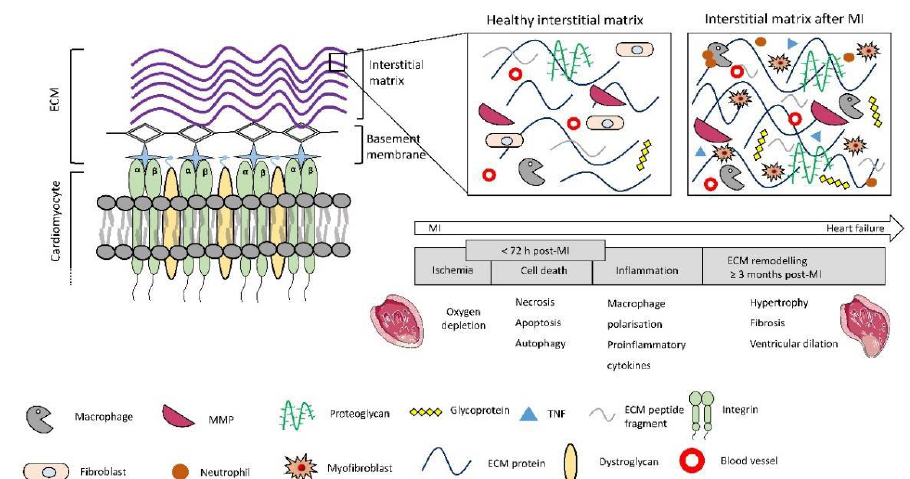
Figure 2. ECM components: Interstitial matrix consists of fibrillar collagen, elastin, proteoglycans and glycoproteins, basement membrane is made of non-fibrillar collagen and laminin. Cardiomyocytes attach to the basement membrane via transmembrane proteins such as integrin and Dystroglycan. The excessive ECM secretion after the infarction leads to tissue hypertrophy and scar formation. The figure of the MI heart was adopted from the Servier Medical Art under the CC BY 3.0 license.